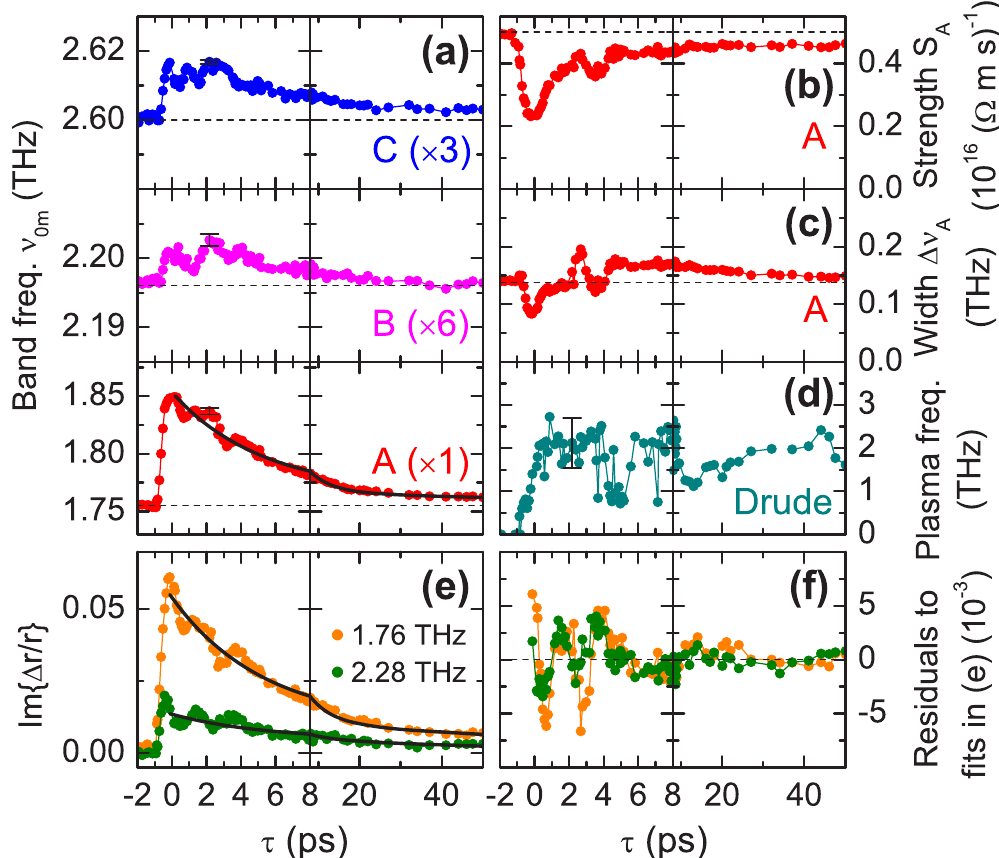
Figure 4. Parameter kinetics for phase-phonon bands and free-carrier response. Results of fitting Δ r / r 0 data in Fig. 3 ( T = 50 K) vs. pump-probe delay τ . ( a ) Band frequencies ν 0 n for the three bands n = A,B,C. GS values obtained during global fit indicated by dashed horizontal lines. ( b , c ) Band strength and bandwidth (FWHM) for Band A, respectively. ( d ) Fitted Drude plasma frequency ν pl for free-carrier contribution. Note that the fluctuations at later delays arise due to small drifts and noise during the measurement run, and any structure should rather be attributed to the non-monotonic order of delays used for the measurement run. ( e ) Experimental kinetics of Im{ Δ r / r 0 } at two selected frequencies, as indicated, and global bi-exponential fit (solid curves). ( f ) Corresponding residual from fitting in ( e ). Representative confidence intervals in the fitted frequency shifts and plasma frequency indicated by the error bars in ( a , d ), respectively (see Fig. 5(b,d) for errors in the GS